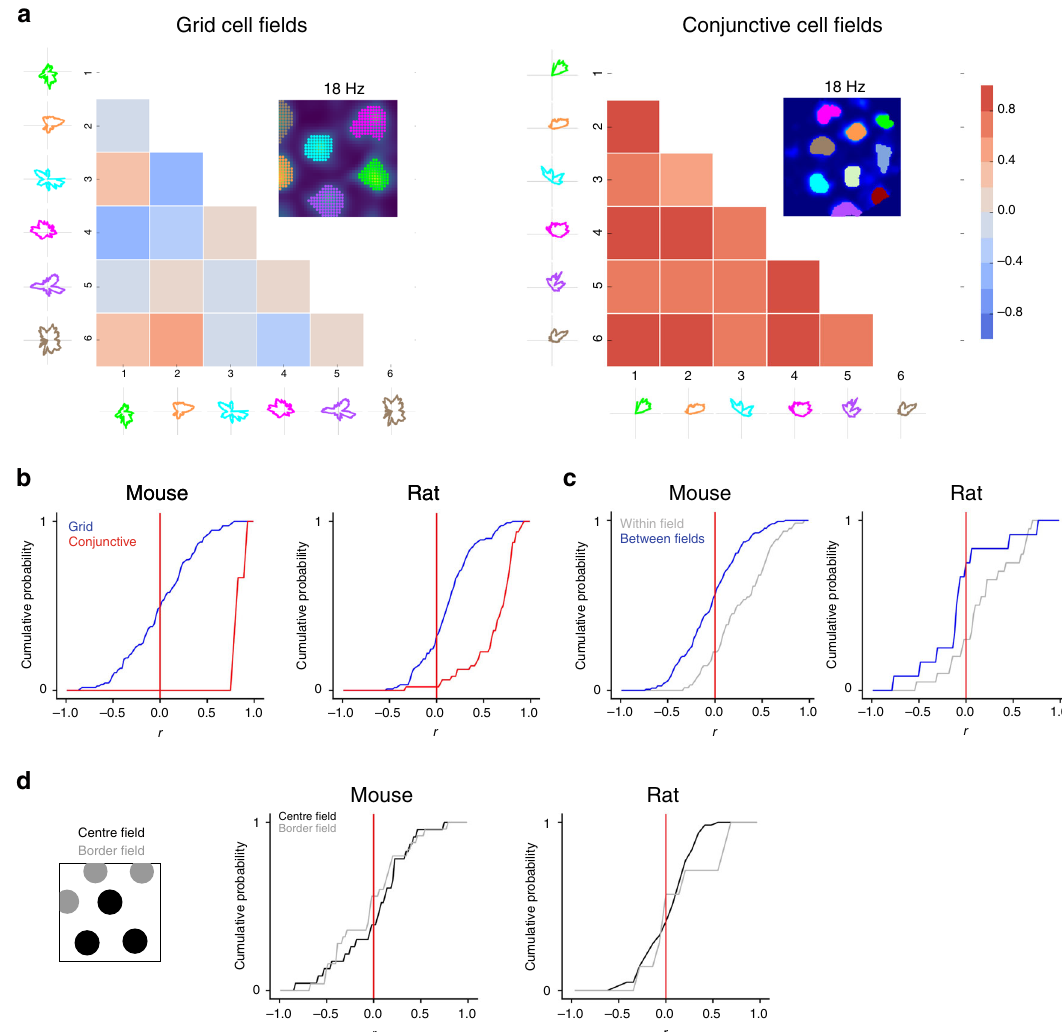
Fig. 4 Directional modulation depends on location. a Example of pairwise correlation of directionally binned fi ring of a pure grid cell (left) and a conjunctive cell (right). b Distribution of the coef fi cients obtained by Pearson correlation between different fi elds from the same grid or conjunctive cells calculated as in a . The distribution for grid cells differed from the distribution for conjunctive cells (for mice: D = 0.98, p = 1.5 × 10 − 8 ; for rats: D = 0.72, p = 2.2 × 10 − 16 ; two-sided Kolmogorov – Smirnov test). c Correlations between fi ring rate histograms for the same fi eld (blue) and between different fi elds (grey) generated from data from the fi rst and second halves of each session. The distribution of correlation coef fi cients for the within- fi eld correlations differed from the between- fi eld correlations (for mice: p = 3.3 × 10 − 6 , D = 0.38; for rats: p = 0.018, D = 0.53; two-sided Kolmogorov – Smirnov test). d Border and centre fi elds were de fi ned based on whether they contacted the border of the enclosure (left). Cumulative histograms show the distribution of correlation coef fi cients calculated as in b but with central and border fi elds shown individual fi elds, their classic head direction plots were also posi- of other fi elds from the same grid cell, these data indicate that tively correlated (median Pearson correlation = 0.29 ± 0.31; directional modulation of grid cell fi ring depends on location. Fig. 5e – g) and 8/44 fi elds had correlation scores in the 95th per- centile of the shuf fl ed data (Fig. 5h). These results are similar to predictions from ‘ ground truth ’ data generated by simulations of spiking models of directionally modulated pure grid cells (see below and Supplementary Fig. 14). These simulations predicted correla- tion scores between the fi rst and second half of each session for global (median = 0.38 ± 0.27) and local (median = 0.58 ± 0.30) directional modulation that were comparable to the experimental data (Supplementary Fig. 14). They also predicted a similar pro- portion of correlation scores in the 95th percentile of the corre- sponding scores generated from the shuf fl ed data (all cells: 12/19; fi elds: 29/106; Supplementary Fig. 14). Thus global directional modulation of pure grid cell fi ring appears stable at the time scale of single recording sessions.